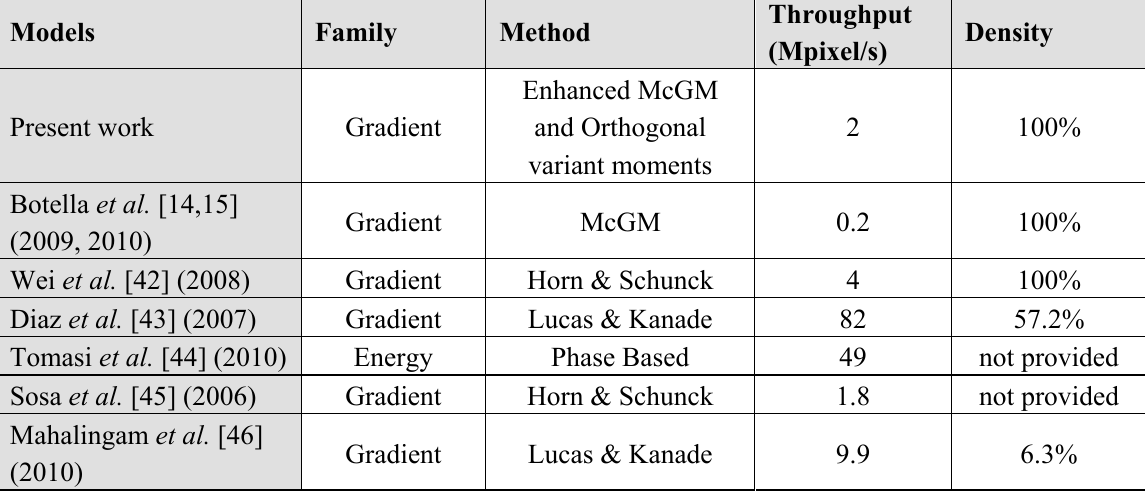
Table 5 . Comparison with other complex system vision